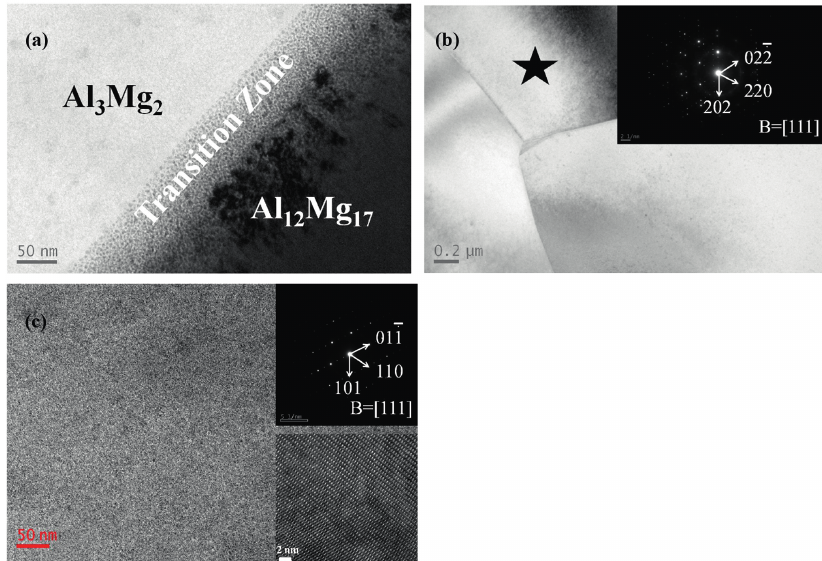
Figure 3: TEM micrographs of the Mg/Al joint (a) Mg/Al joint; (b) near the Al-matrix; (c) near the